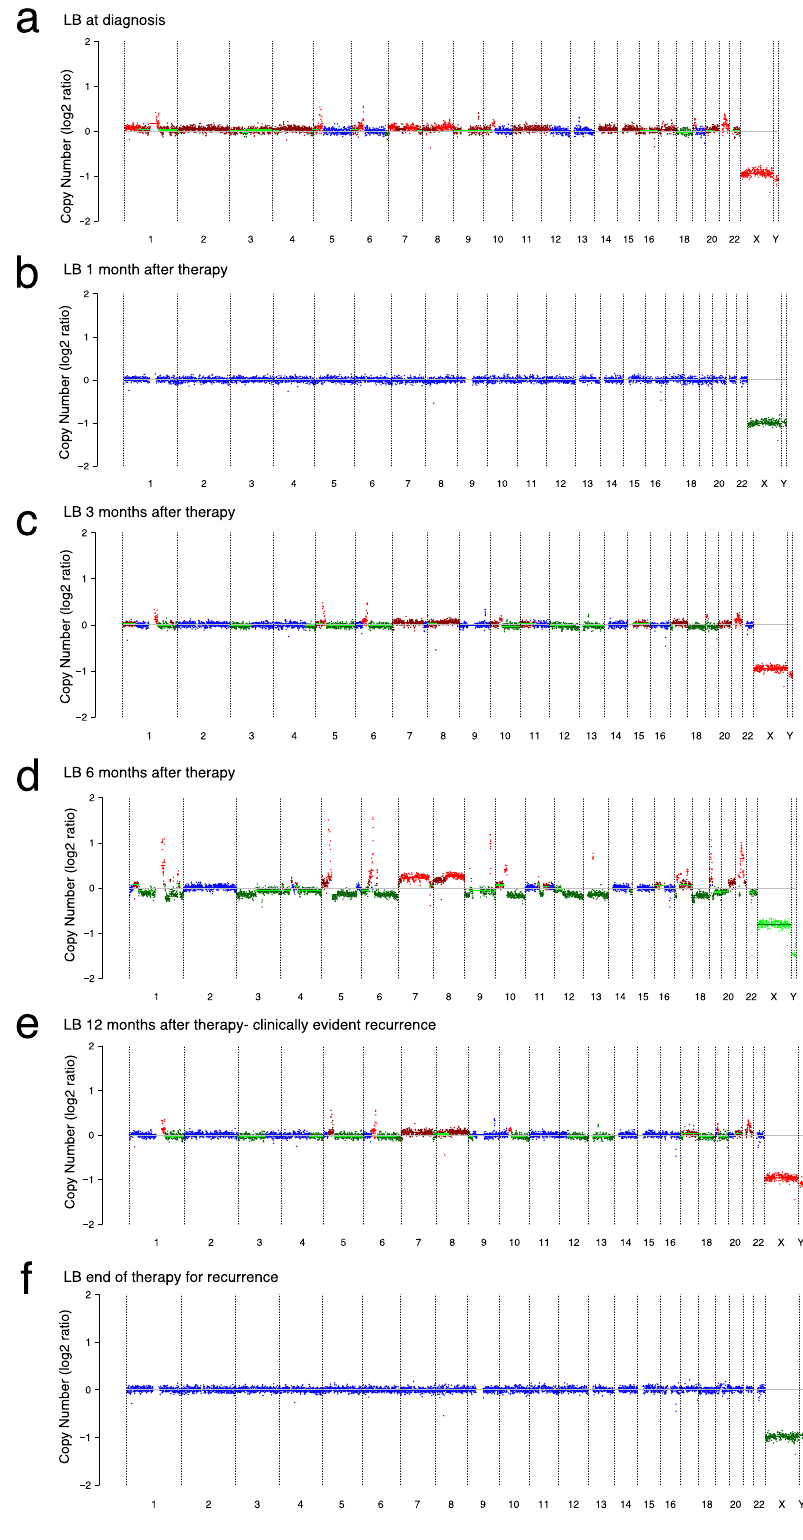
ctDNA data and OncoKids ® tumor data across all pediatric solid tumor cases. Further studies are required to determine if this approach will be clinically feasible on a prospective basis, at least for some patients, or whether a companion targeted capture NGS- based panel approach will be